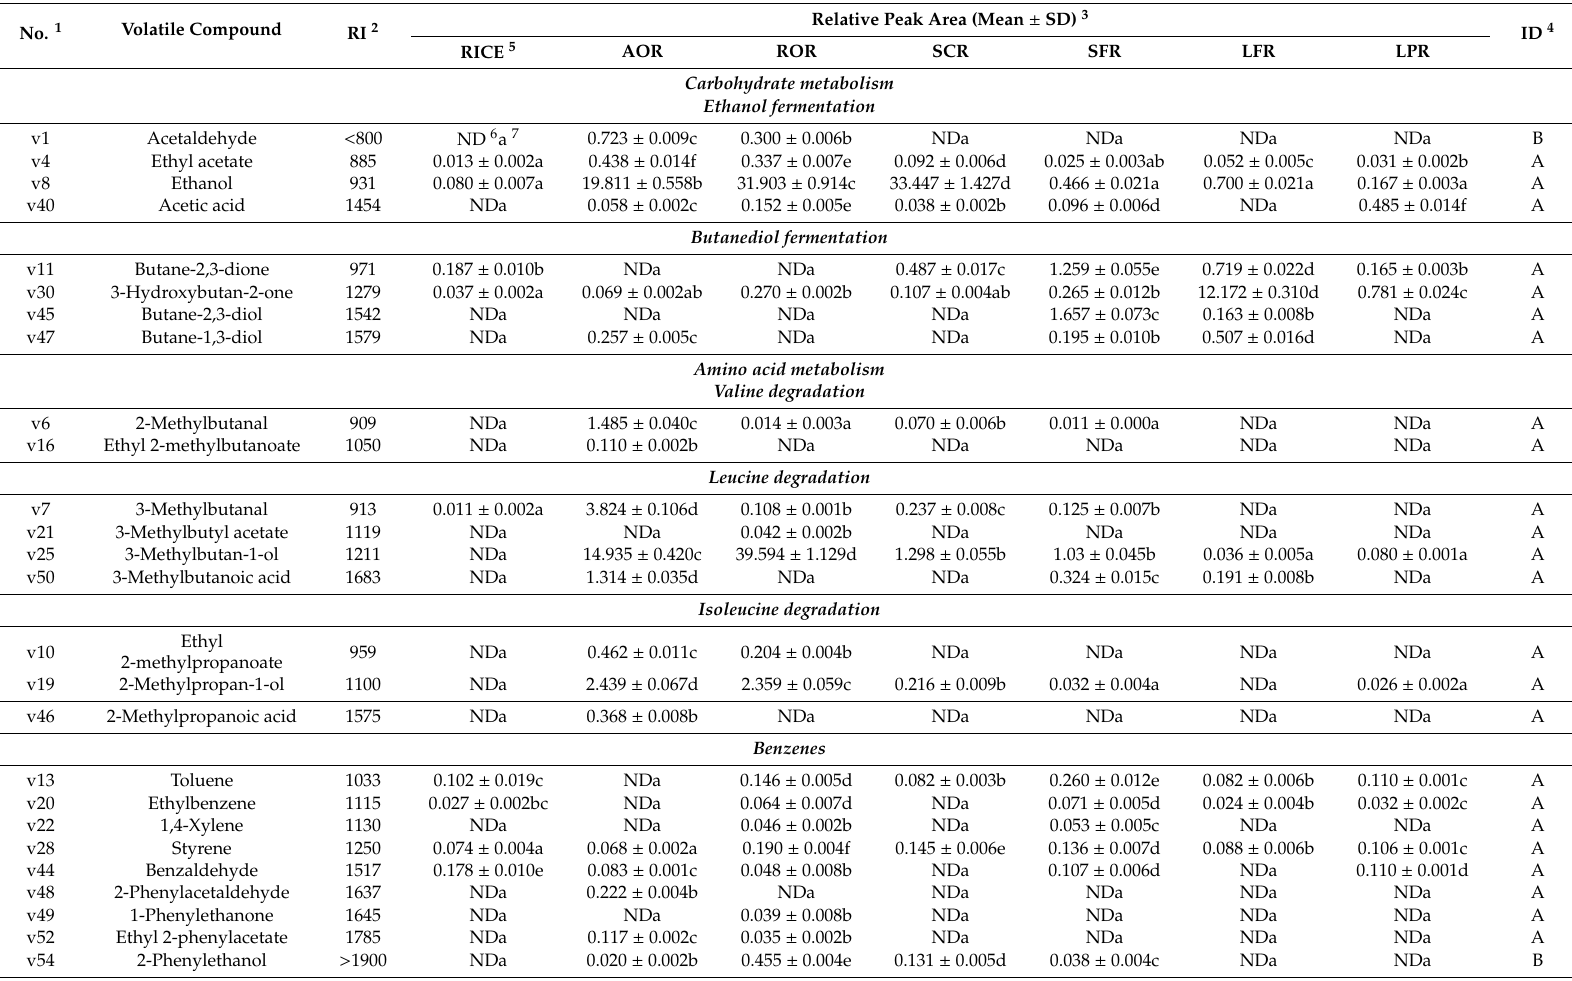
Table 2. Volatile compounds identified in fermented rice inoculated by di ff erent